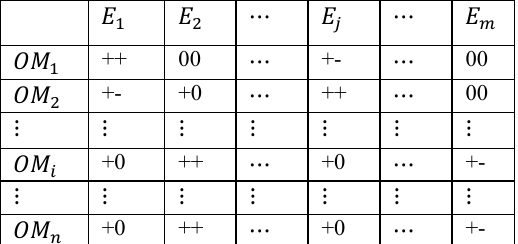
Table 1. The qualitative matrix adapted from Peysson et